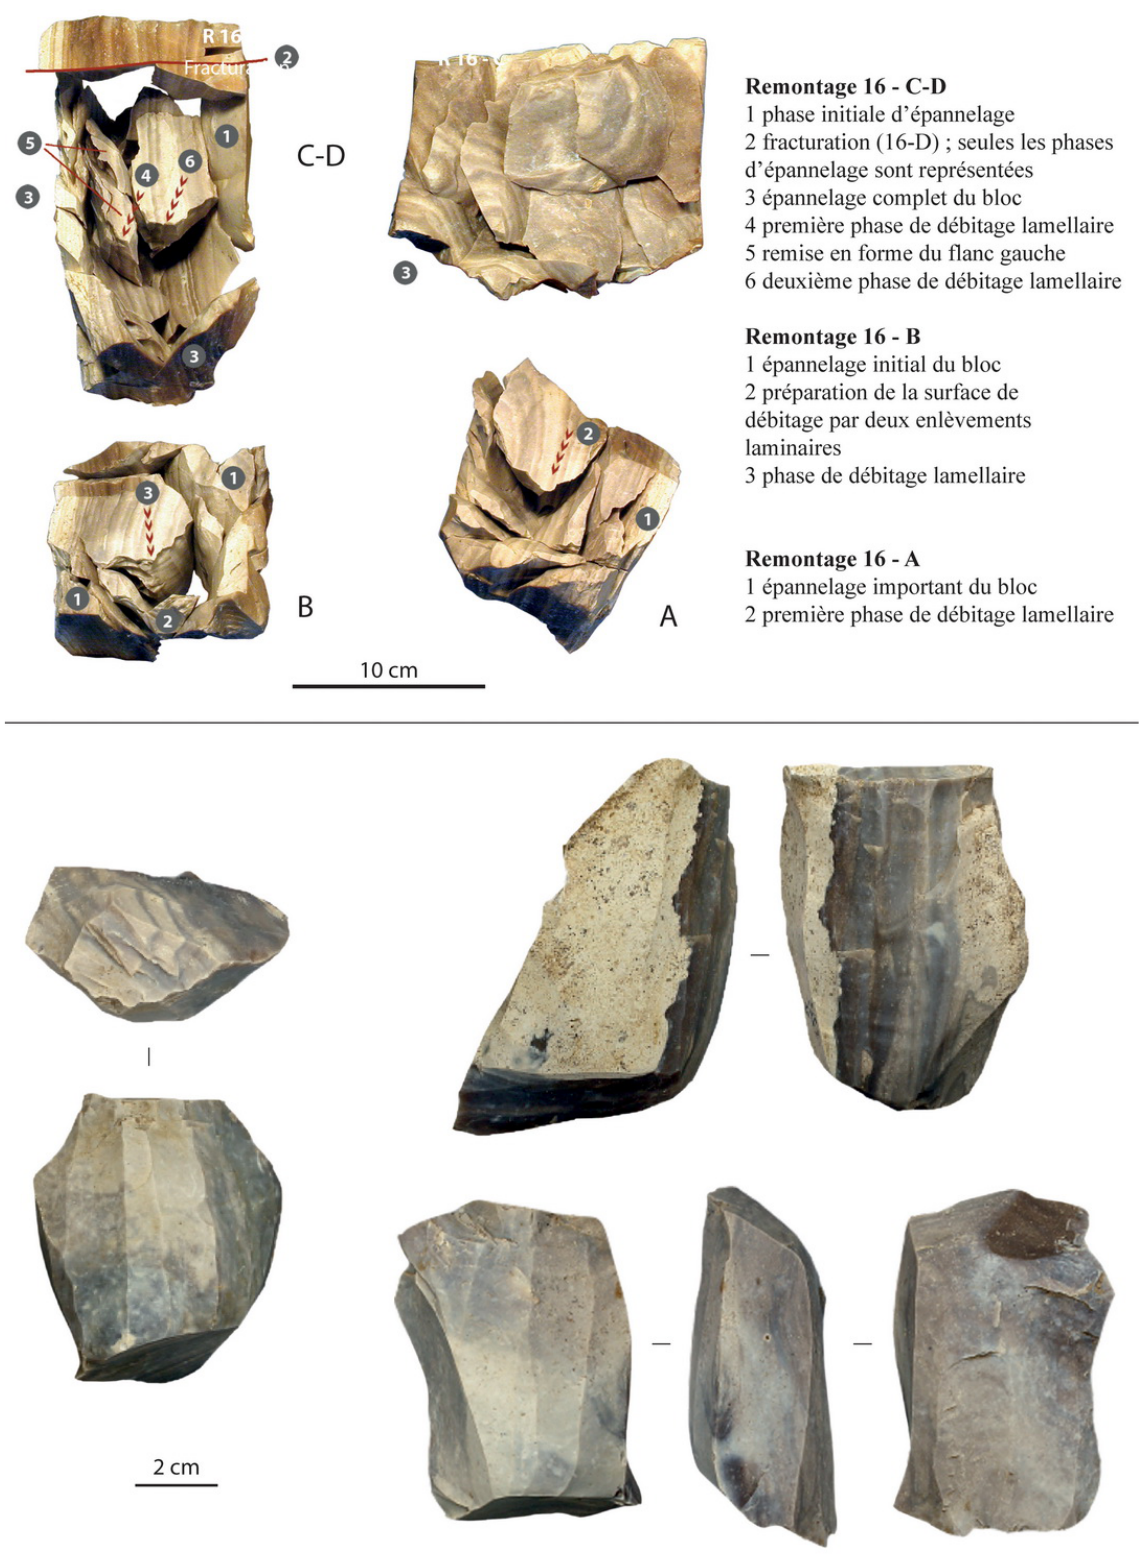
Figure 4. Lhéry (Marne). En haut: Ensemble de remontages d’une dalle en silex tertiaire (Séara 2014: 48 modifié). En bas: Exemples de nucléus à lamelles du Second Mesolithique similaires à la méthode de l’Essart A (d’après Séara 2014: 47). Figure 4. Top: Refit of a tabular tertiary flint (Séara 2014: 48 modified). Below: Examples of Second Mesolithic bladelet cores similar to the Essart A method (after Séara 2014: